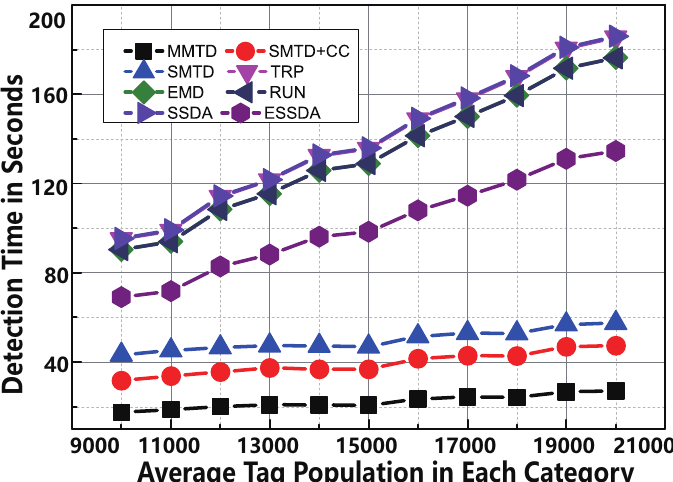
Figure 9. The comparison of time-efficiency between MMTD and other missing tag detection proto- cols when µ is set to be from 10,000 to